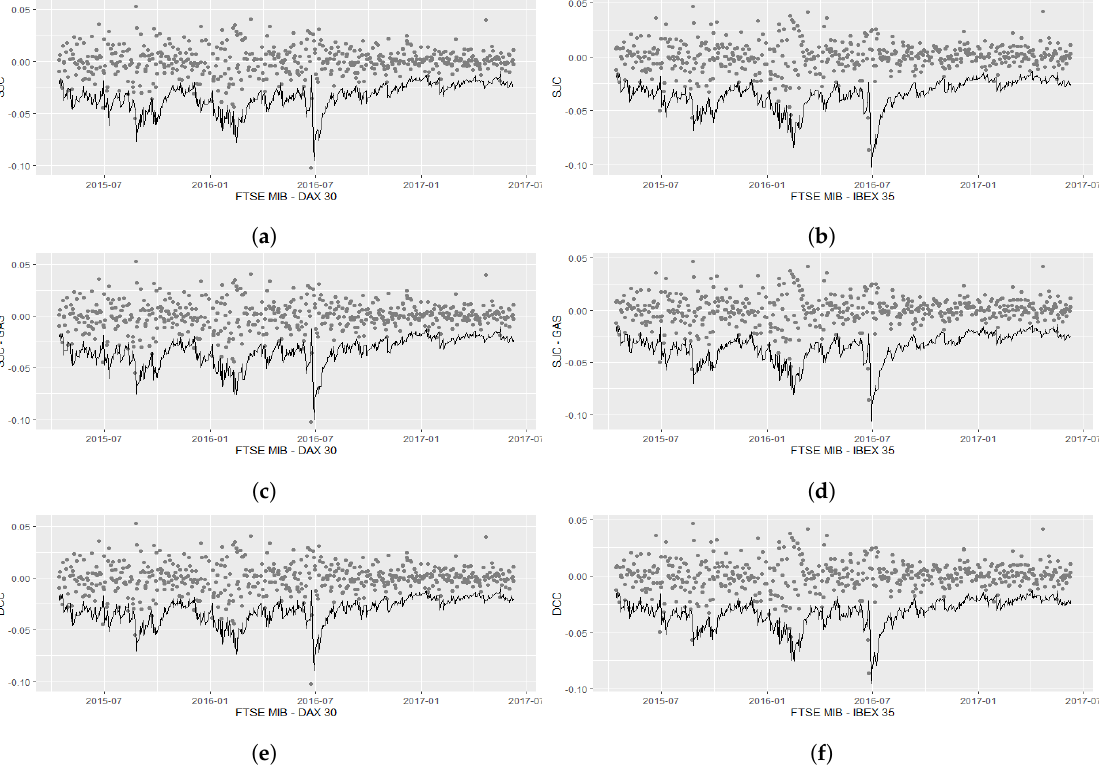
Figure 5. Value-at-Risk (VaR) forecasts time patterns considering an SJC copula with dynamic Equation (6) ( a , b ), an SJC–GAS copula ( c , d ), and a DCC model ( e , f ). ( a , c , e ) refer to the FTSE MIB–DAX 30 portfolio VaR, while ( b , d , f ) to the FTSE MIB–IBEX 35